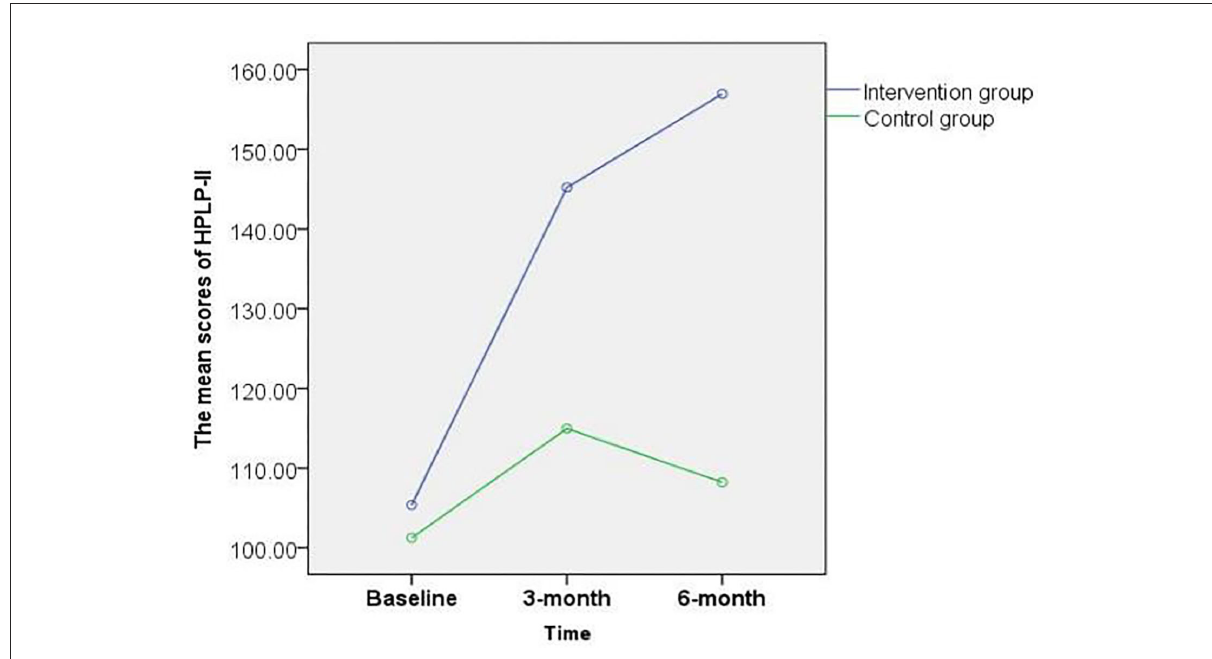
FIGURE2 Total score changes in healthy behavior at baseline, third, and sixth month post-intervention among the PCOS patients.